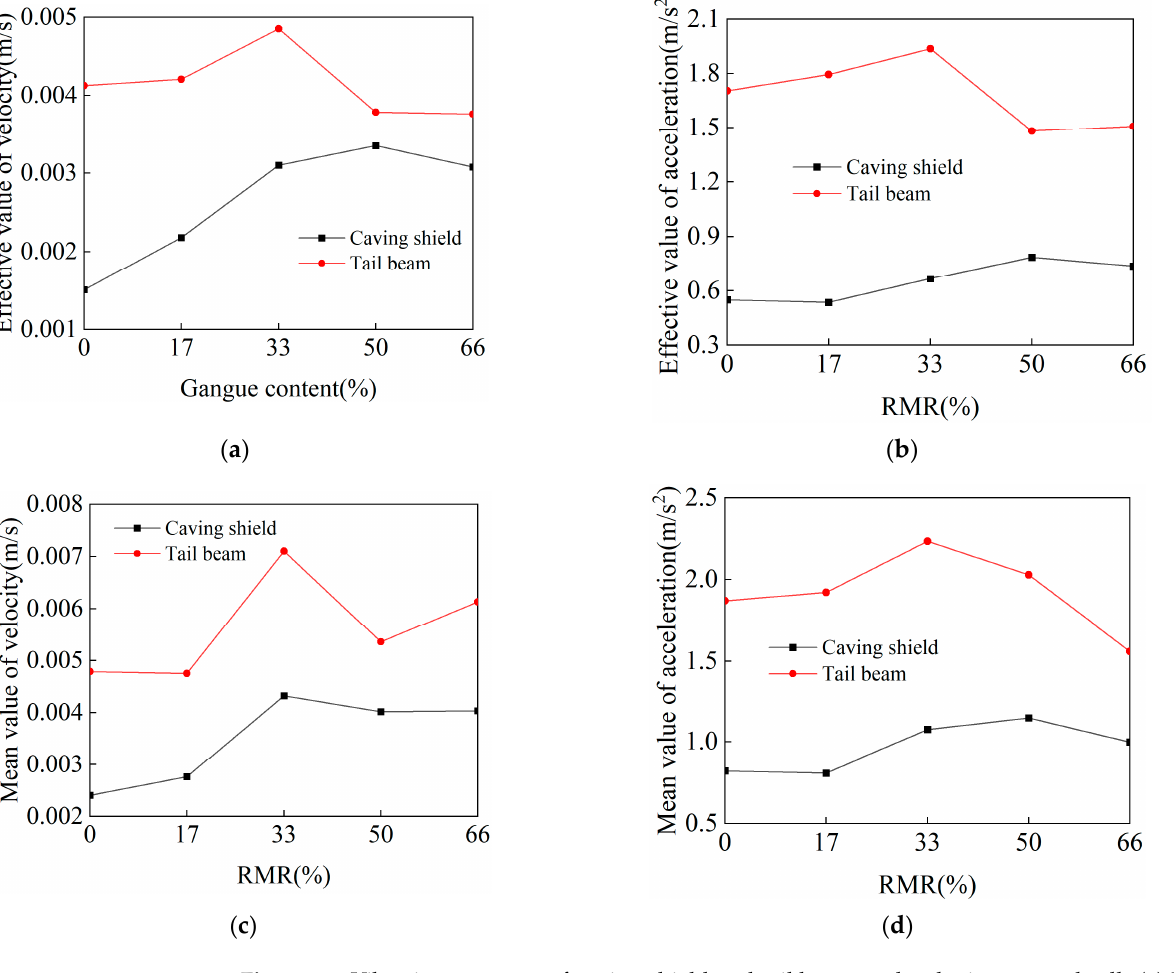
Figure 17. Vibration response of caving shield and tail beam under the impact and roll. ( a ) RMR versus effective value of velocity. ( b ) RMR versus effective value of acceleration. ( c ) RMR versus mean value of velocity. ( d ) RMR versus mean value of acceleration.